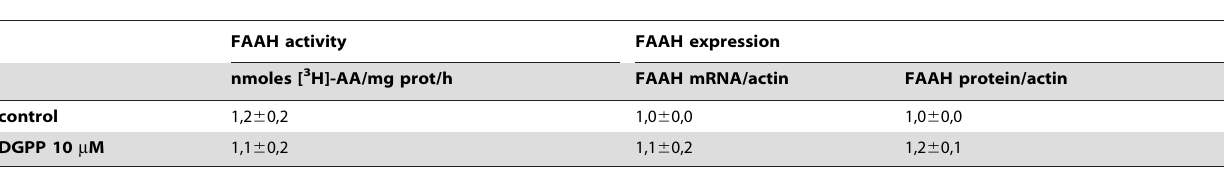
Table 3. Effect of DGPP 10 m M on FAAH activity and expression.